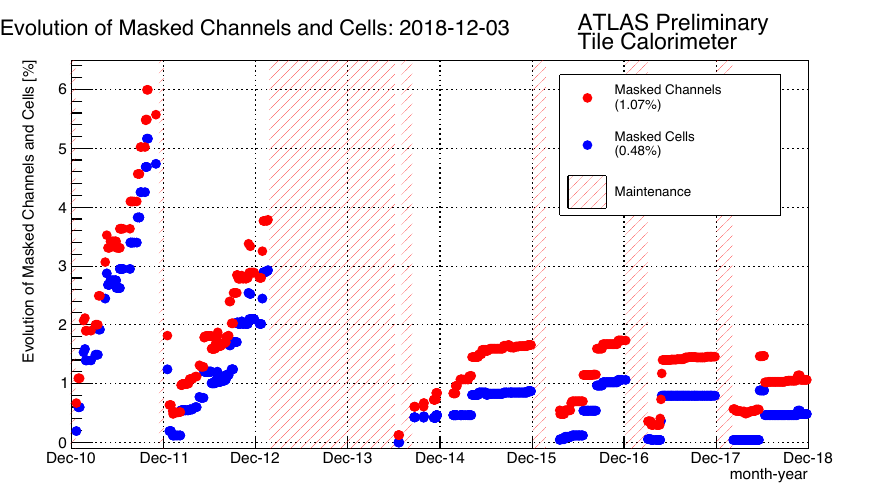
Fig. 7. Evolution of masked TileCal channels and cells. Figure is taken from Ref.